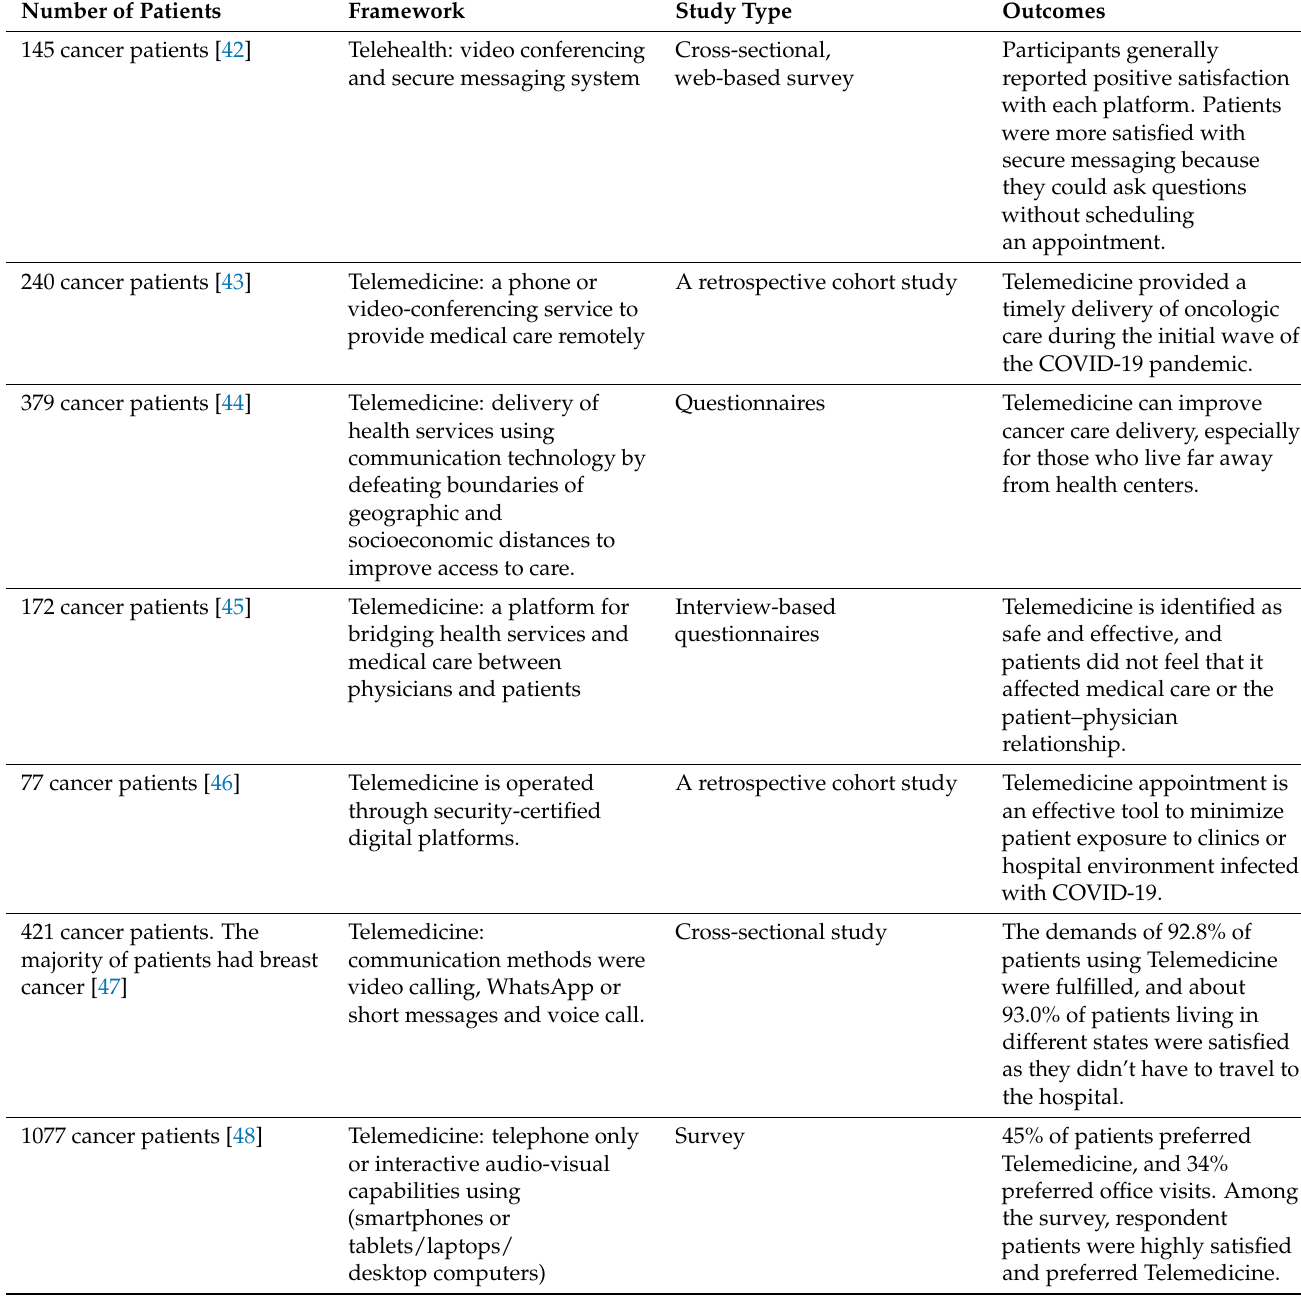
Table 1. Effectiveness of different patient care frameworks among cancer patients during